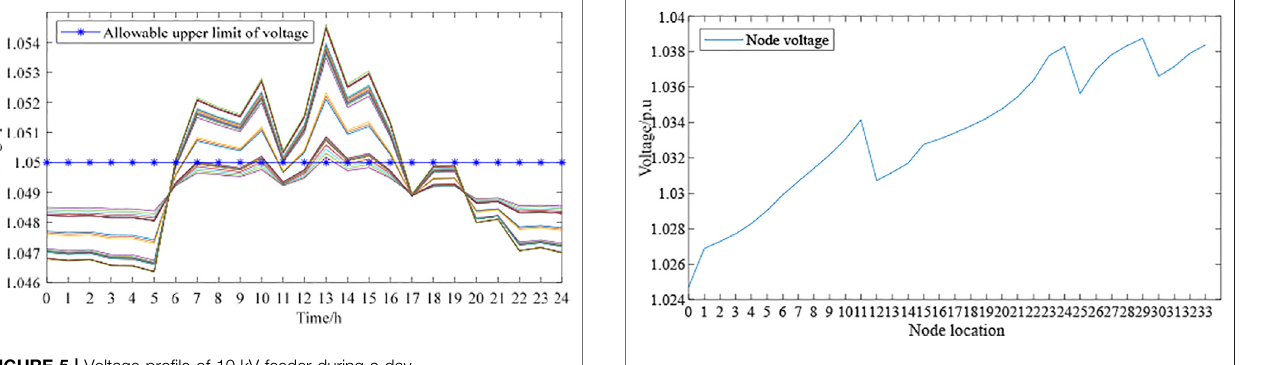
FIGURE 5 | Voltage pro fi le of 10 kV feeder during a day.